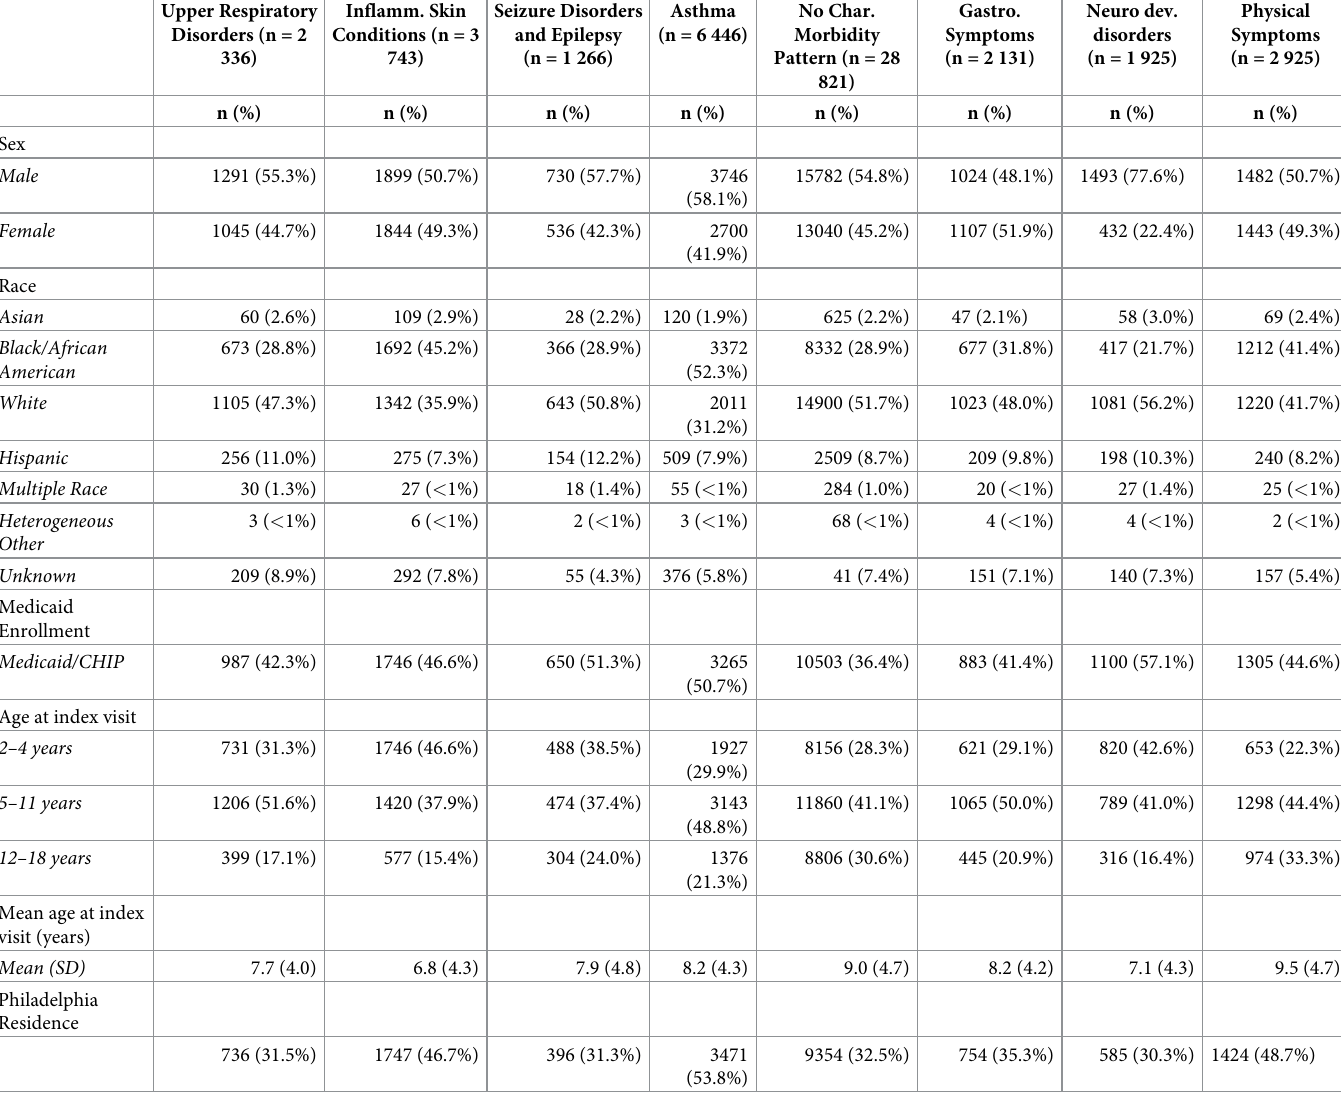
Table 6. Demographic Characteristics of Obesity Incidence Study Population Clinical